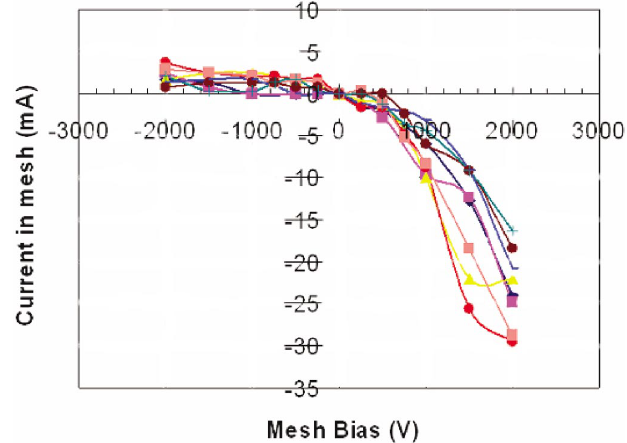
FIG. 19. (Color) Mesh current when applying voltage across the mesh. Different lines correspond to different energies, ranging from 244 to 320 keV.